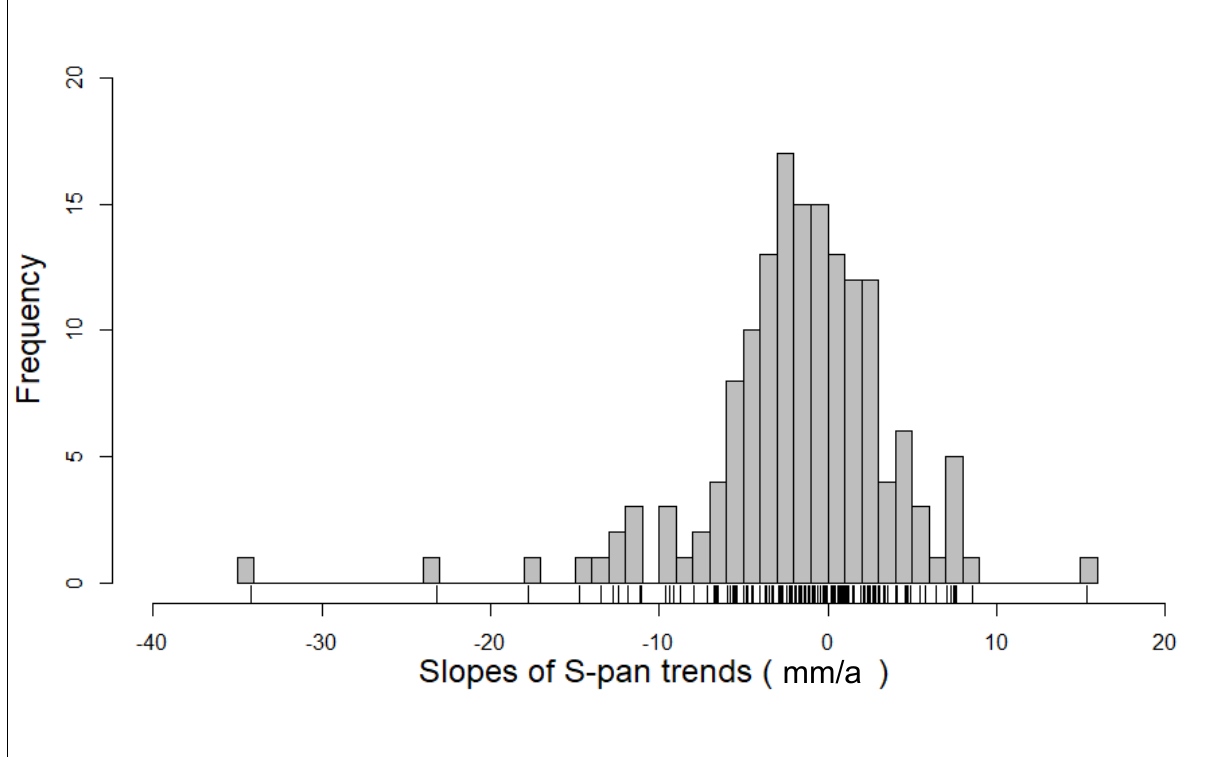
Figure 1: The distribution of changes in mm/a in S-pan evaporation for all results ( n =154) as represented by the slopes in linear